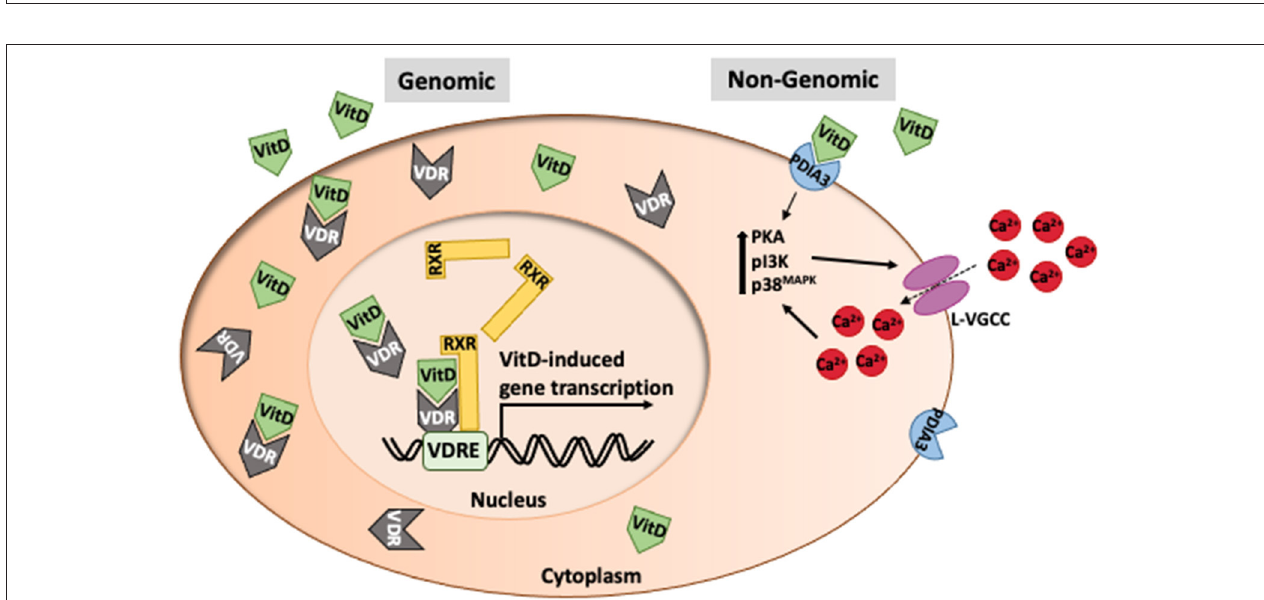
FIGURE 1 | Vitamin D production pathway. Vitamin D3 is produced in the skin by UVB irradiation. Typically, the liver and kidney generate intermediates that ultimately generate calcitriol, the active form of VitD. The brain and immune cells also express the enzyme that allows for the generation of calcitriol.